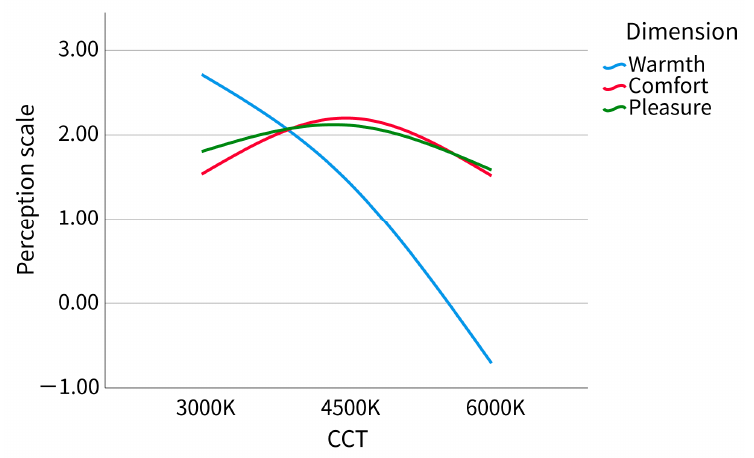
Figure 9. Perception scale.